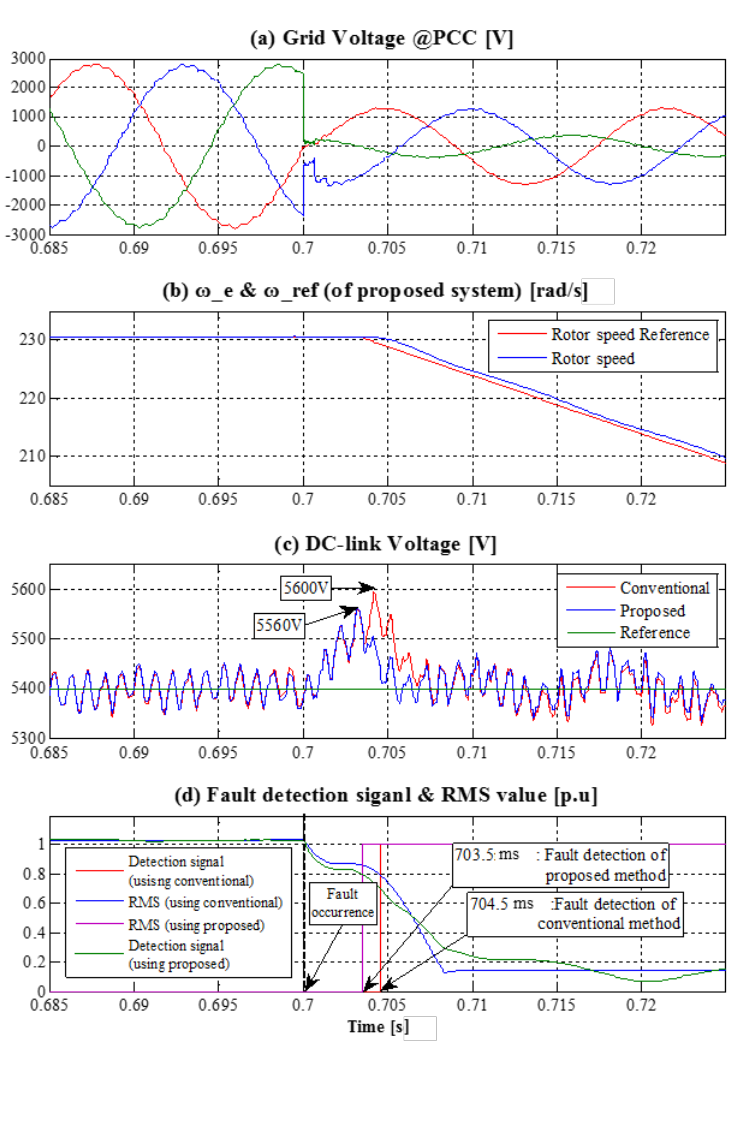
Figure 11. Simulation results of Case 2: ( a ) grid voltage waveforms; ( b ) the rotor speed of the PMSG; ( c ) DC-link voltage of the full-scale inverter; and ( d ) fault detection according to the measure RMS